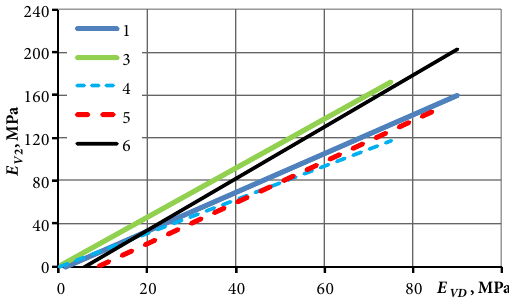
Fig. 3. Test results (Ustinovičius 2015), combined with Lithuania recommended conversion values. 1 – experimental values, 2 – values according to (Lietuvos automoblių ... 1995)